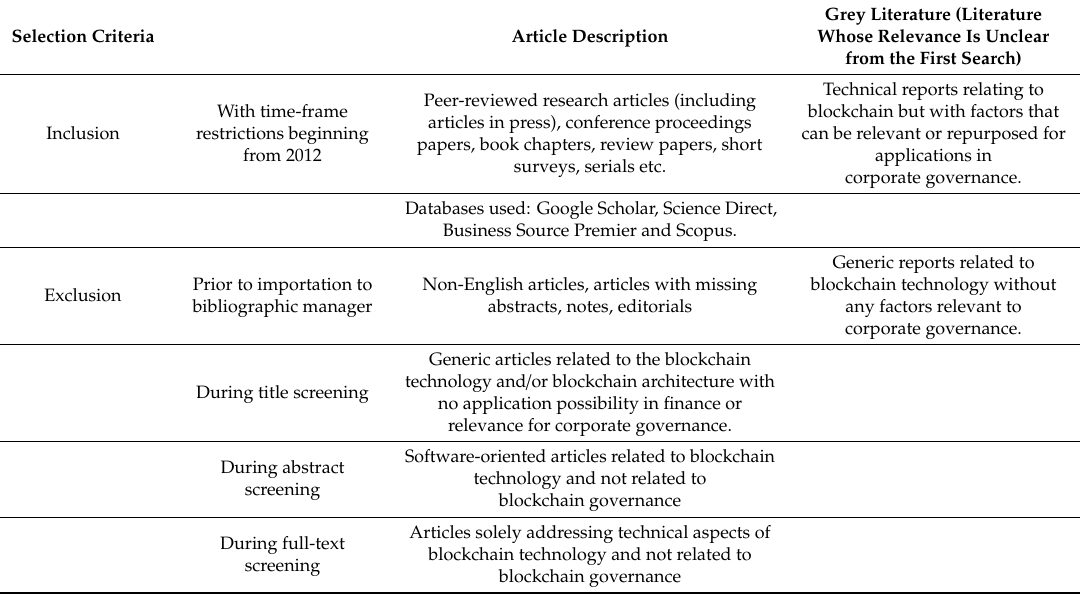
Table 1. Inclusion and exclusion